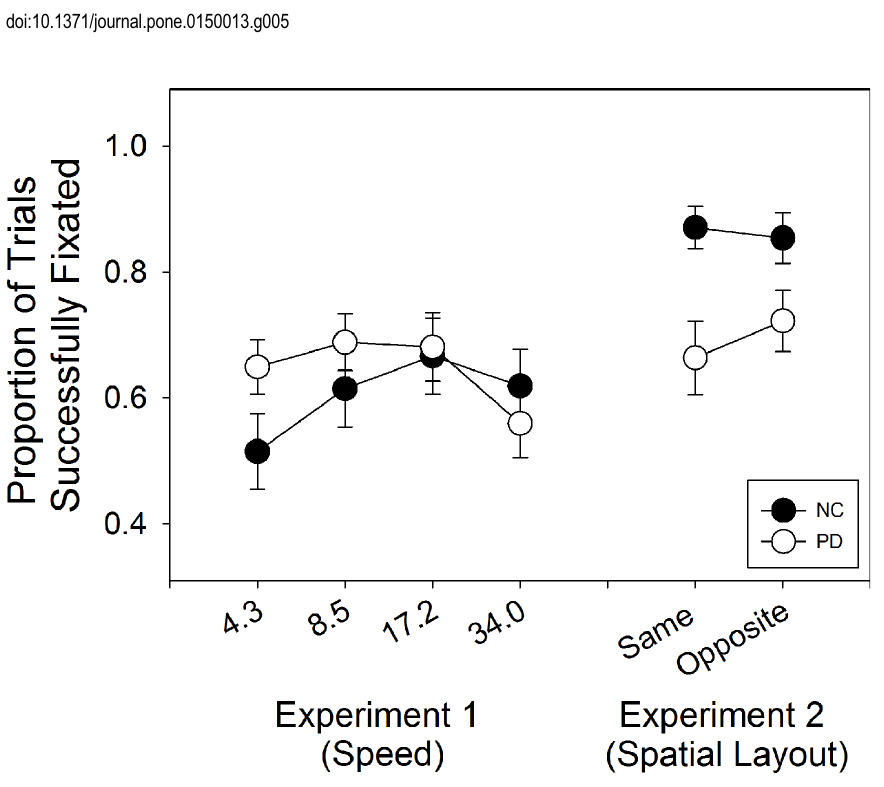
Fig 6. Proportion of trials fixated in Experiments 1 and 2. In Experiment 1, a significant interaction between group and stimulus speed emerged, and in Experiment 2, a main effect of group was present, with PD fixating successfully less frequently than